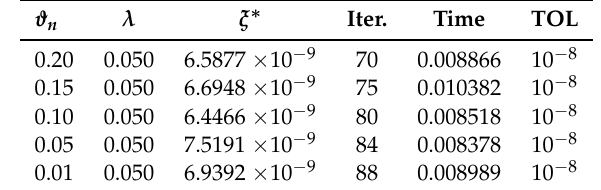
Table 6. Experiment in Section 6.2.1: Algorithm 1 performance for varying parameters extrapolation factor ϑ n .